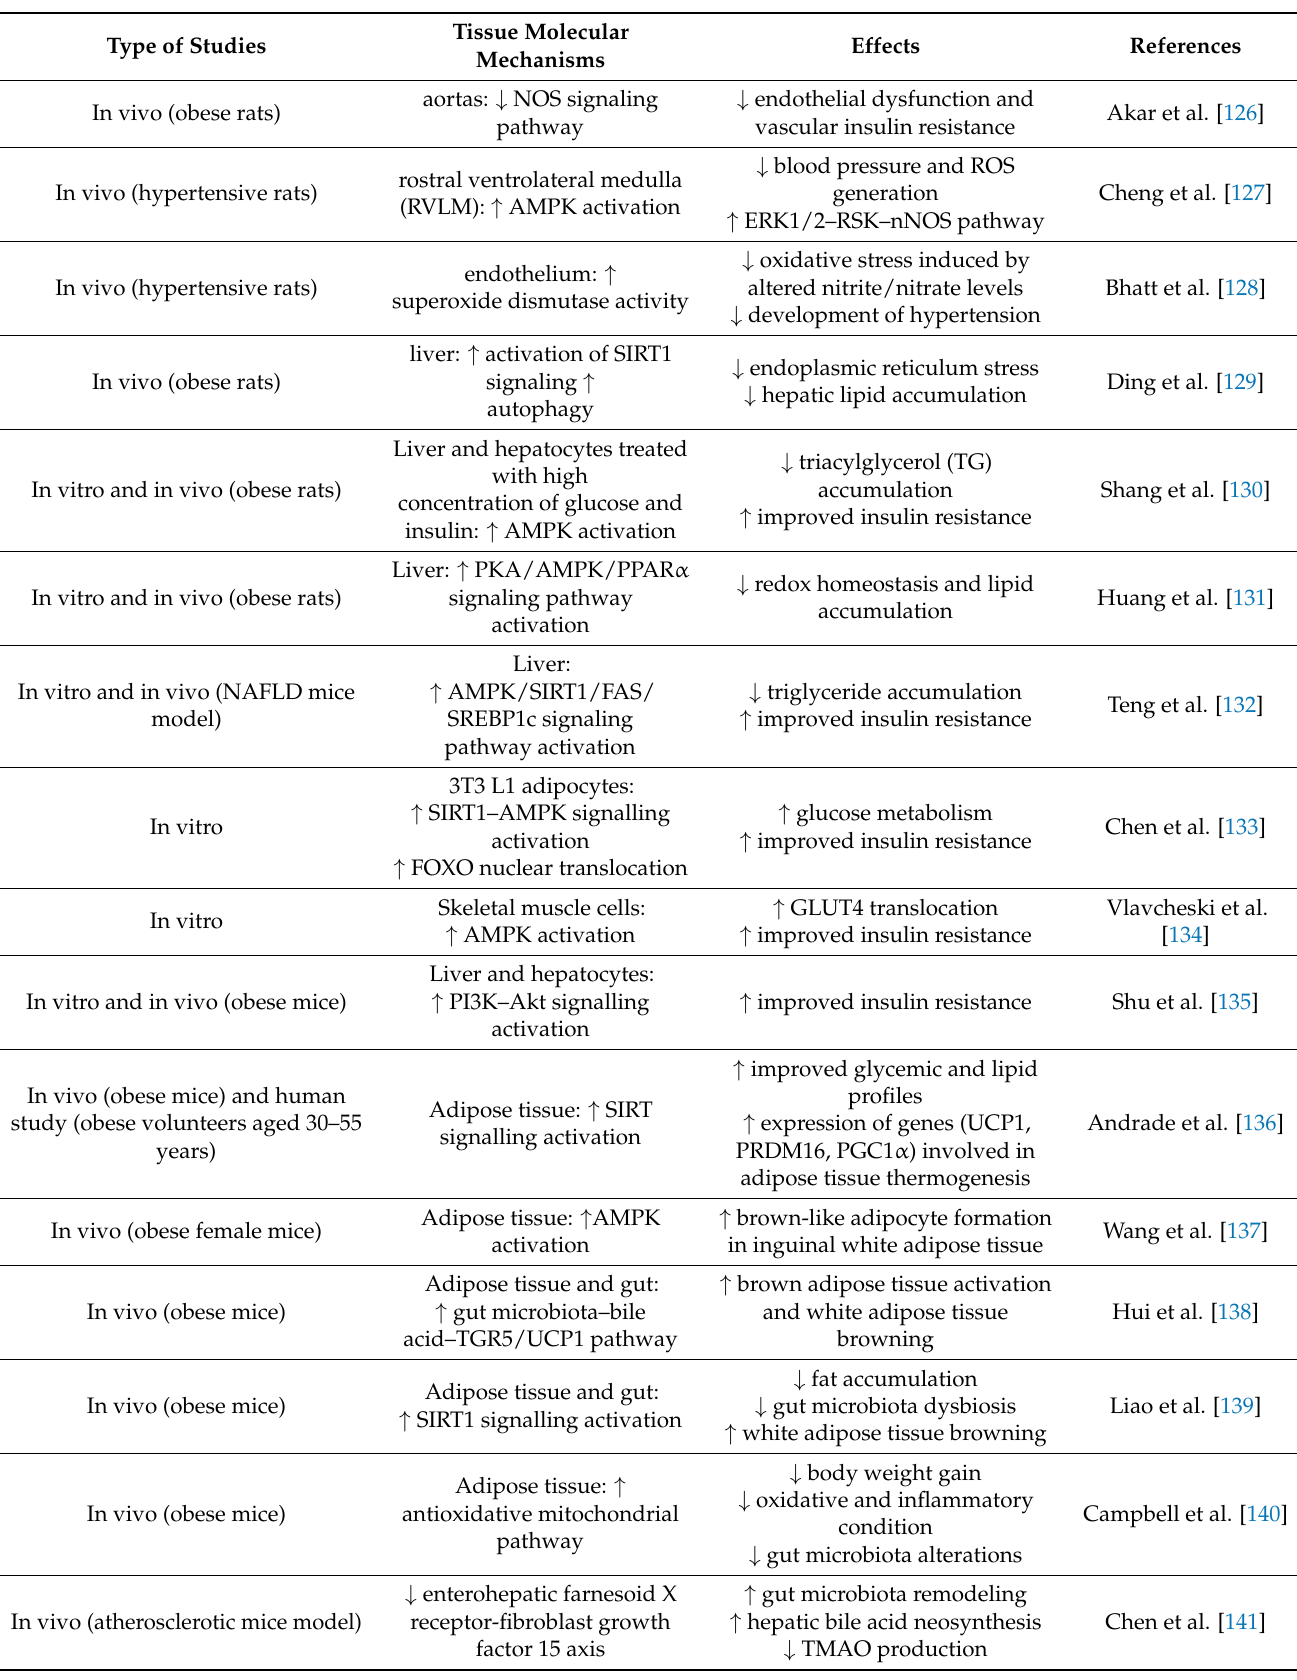
Table 2. Resveratrol as a CR-related nutrient (N.D. = no date, ↑ increase/improvement, ↓ decrease/worsening). Type of